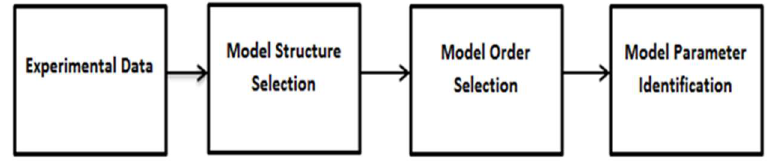
Figure 3. Identification of the grey box model.